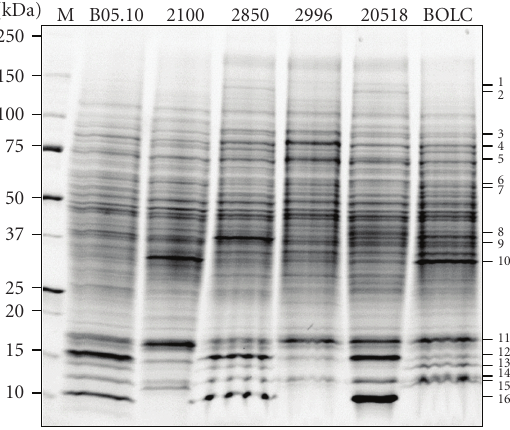
Figure 3: One-DE of 15 μ g of mycelium protein extract of six di ff erent strains of B. cinerea (B05.10, CECT 2100, CECT 2850, CECT 2996, CECT 20518, BOLC (isolated from infected lentil plants)). This approach allowed us to observe di ff erences in the protein band patterns among strains. The bands were cut out and the protein identification was made using MALDI-TOF/TOF MS/MS, and PMF search and a combined search (+MS/MS) were performed in nrNCBI database of proteins using MASCOT. Some of these proteins identified have been reported to be involved in pathogenicity in B. cinerea or in other phytopathogenic fungi, such as malate dehydrogenase (10), woronin body major protein (11), peptidyl-prolyl cis-trans isomerase (14) and PIC5 protein (15), or implicated in fungal growth and di ff erentiation, such as nucleoside diphosphate kinase (12). The abundance of these proteins was di ff erent among isolated (Gonzalez-Fernandez et al . , unpublished